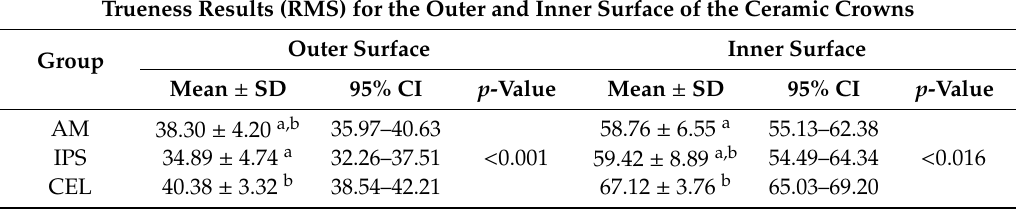
Table 3. Results of trueness Root Mean Square (RMS) for outer and inner surfaces of the ceramic crowns. Trueness Results (RMS) for the Outer and Inner Surface of the Ceramic Crowns Outer Surface Inner Surface Group